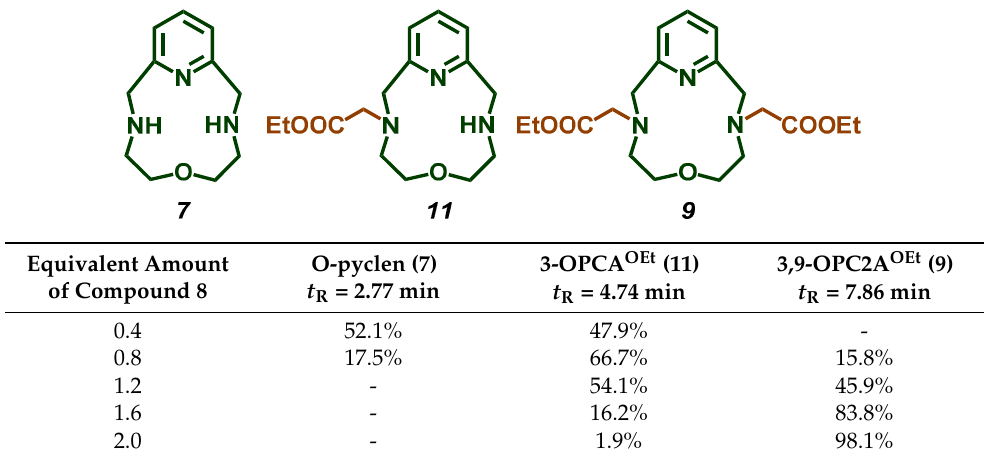
Table 1. The ratio of the formed compounds during the alkylation of the O-pyclen macrocycle with different amounts of ethyl-2-bromoacetate (information about the applied method of analytical HPLC are in the ESI).